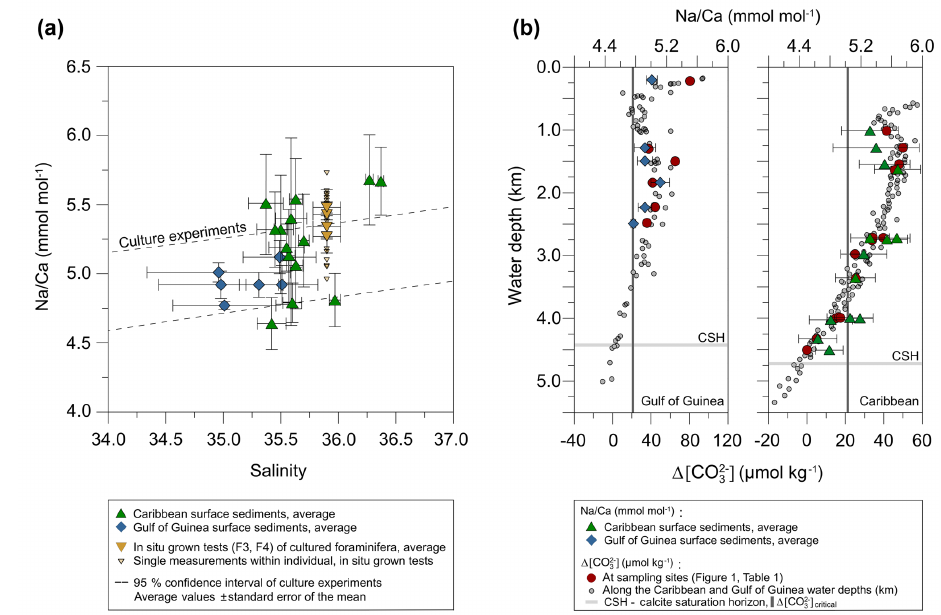
Figure 6. Averaged Na / Ca values of T. sacculifer from surface sediment samples collected in the Caribbean (stations SO164-01-3 to SO164- 50-3, green triangles) and the Gulf of Guinea (stations M6–5 GIK 16808–16869, blue diamonds) (Fig. 1, Table 2). (a) Dashed lines indicate the 95% confidence interval derived from culture experiments (Fig. 3) for comparison. Vertical error bars denote the standard error of the mean derived from replicate measurements (Table 2). Horizontal error bars visualize the salinity range from 0–60m at the respective core locations (Fig. 1), representing the possible habitat migration of T. sacculifer (Hemleben et al., 1987; Schmuker and Schiebel, 2002). ] versus water depth at respective sampling stations (red dots), presented in Table 1, and the entire depth profile (light grey dots) (b) (cid:49) [ CO 2 − 3 ] is defined as the difference between the in situ carbonate ion concentration ( [ CO 2 − in the Gulf of Guinea and the Caribbean. (cid:49) [ CO 2 − 3 [ CO 2 − ] at calcite saturation. Respective calcite saturation states for the Caribbean were taken from Regenberg et al. (2006) due to overlapping 3 sample stations and for the Gulf of Guinea from Weldeab (2012) and Weldeab et al. (2016). Additional data were calculated with the program CO2SYS by Pierrot et al. (2006) (see Sect. 2.3 for a detailed description). The horizontal calcite saturation horizon line marks the top of ] is 0µmolkg − 1 (Regenberg et al., 2006). The vertical line demonstrates the critical (cid:49) [ CO 2 − the present day lysocline, at which (cid:49) [ CO 2 − 3 threshold of 21.3µmolkg − 1 , the onset of Mg / Ca decline in all planktonic foraminifera due to calcite dissolution (Regenberg et al., 2006, 2014, Sect.